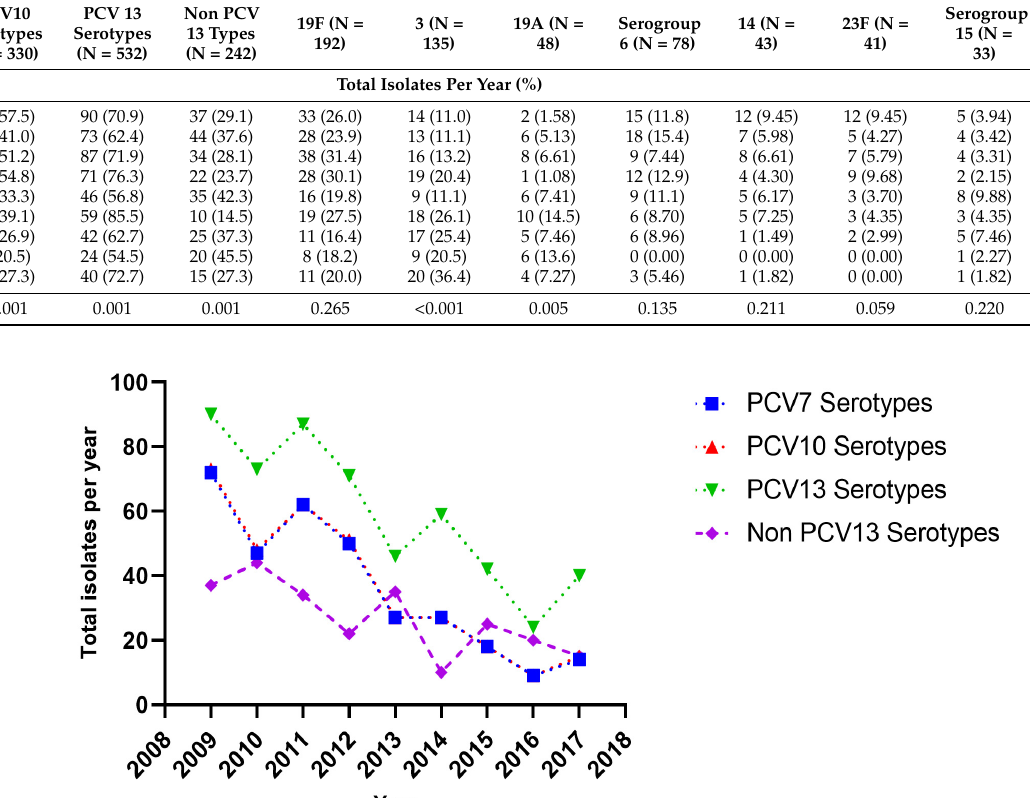
Table 3. Annual changes in the distribution of the major serotypes/groups of pneumococci isolated from adult disease ( p -values by Fisher’s exact test or Chi-square tests).